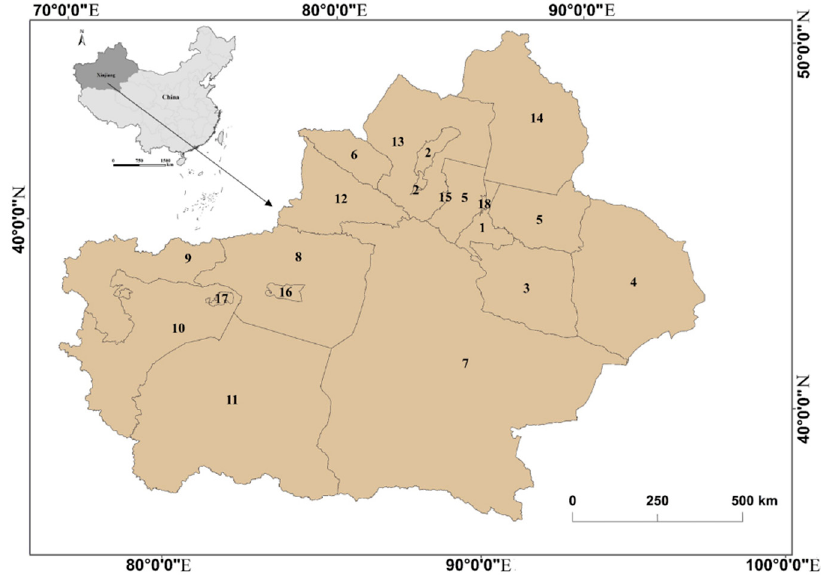
Figure 1. Location map of the study area. Note: Codes 1–18 in the map represent Urumqi, Karamay, Turpan, Hami, Changji Hui Autonomous Prefecture, Bortala Mongol Autonomous Prefecture, Bayingolin Mongol Autonomous Prefecture, Aksu, Kizilsu Kyrgyz Autonomous Prefecture, Kashgar, Hotan, Ili Kazakh Autonomous Prefecture, Tacheng, Altay, Shihezi city, Aral City, Tumxuk, and Wujiaqu City, respectively.